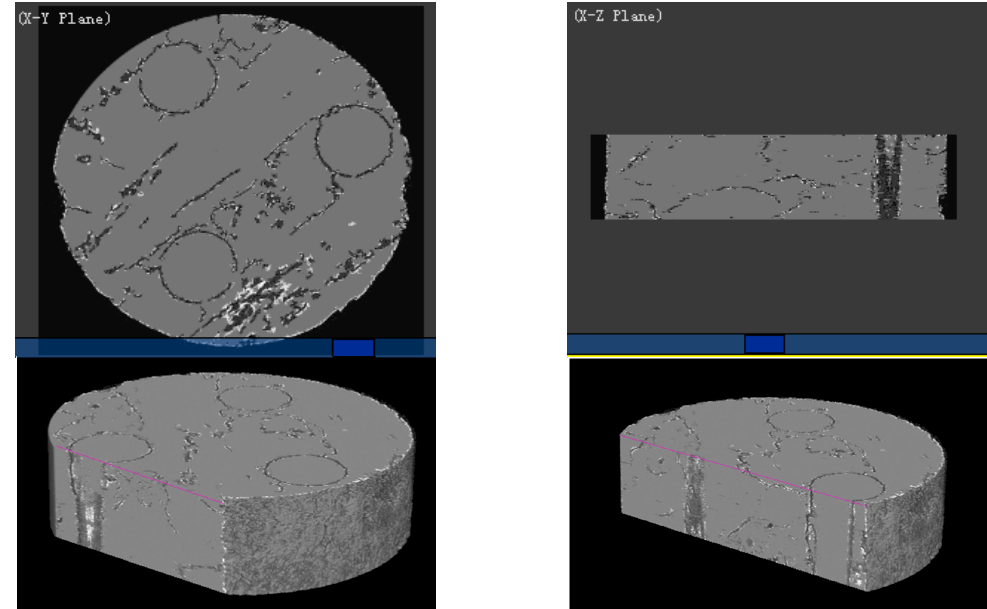
Figure 11. Sectional view of the physical model of the axially braided C/C composites microstructure feature by Micro-CT.